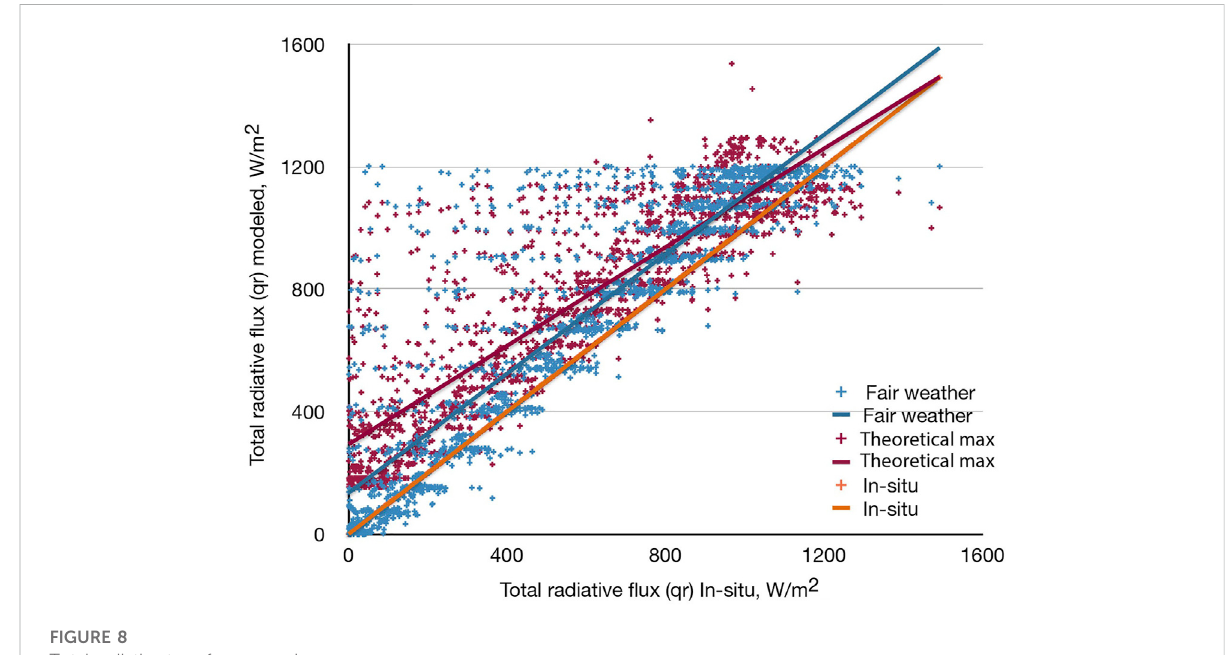
FIGURE 8 Total radiative transfer comparison.